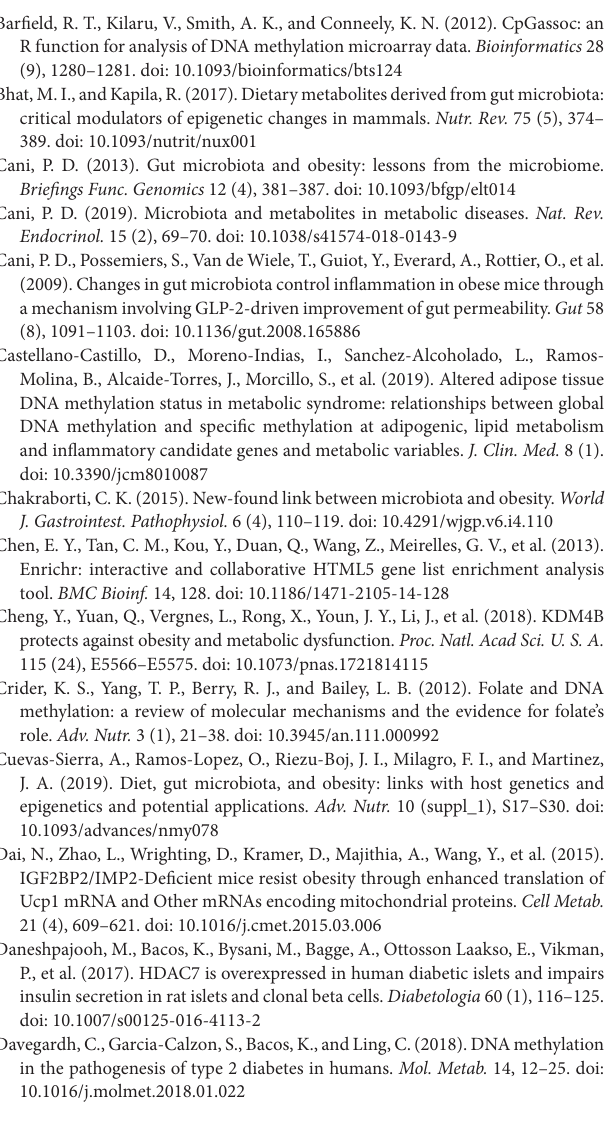
TABLE S2 | Relative abundance of bacterial phyla in fecal microbiota. TABLE S3 | List of genes differentially methylated in whole blood. TABLE S4 | List of genes differentially methylated in visceral adipose tissue.